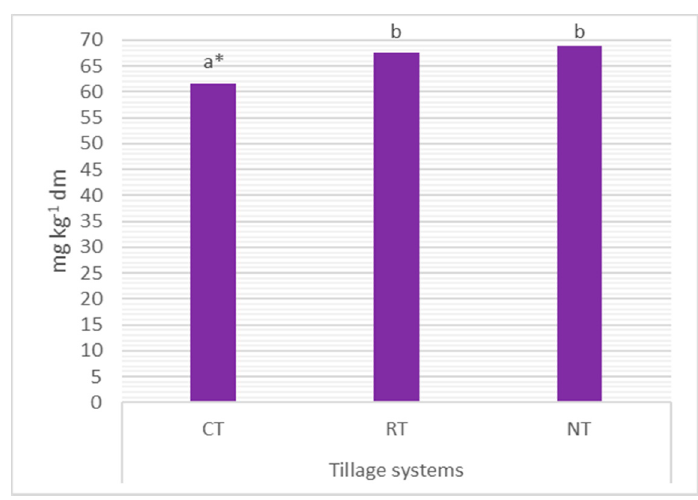
Figure 9. Content of potassium (K) in the 0–25 cm soil layer depending on the tillage system (average of 2014–2016). * a—Means denoted with the same letters do not differ significantly, p < 0.05.